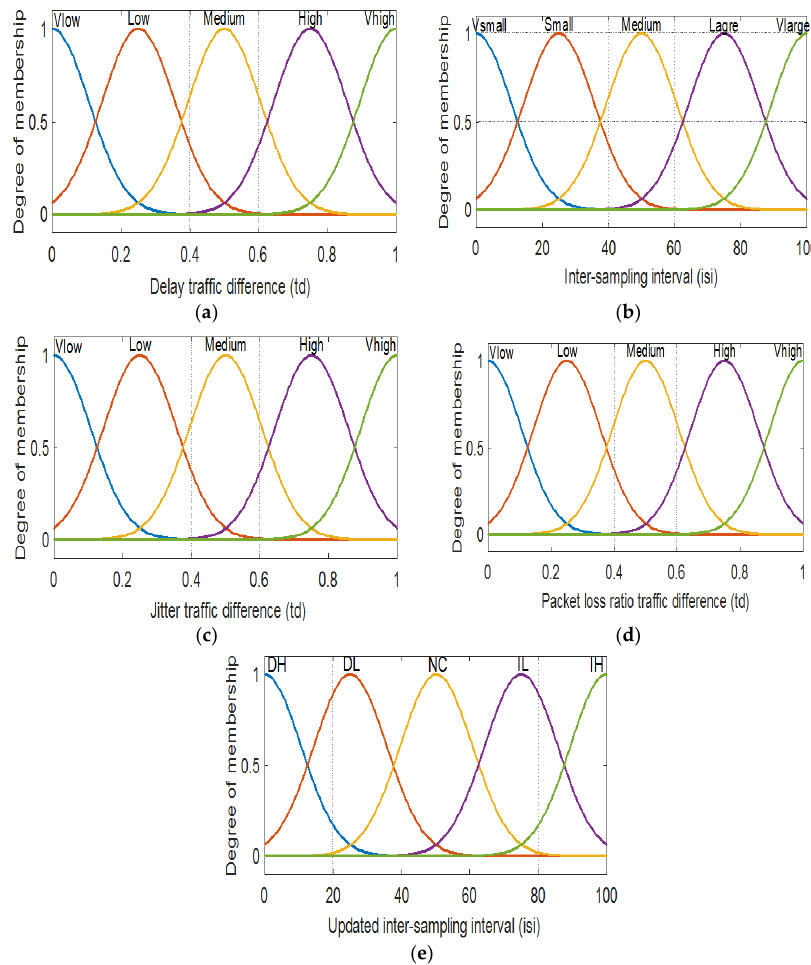
Figure 7. Membership functions for ( a – c ) the Euclidean distance sets for delay, jitter, and percentage packet loss ratio; ( d ) inter-sampling interval; and ( e ) the updated inter-sampling interval.